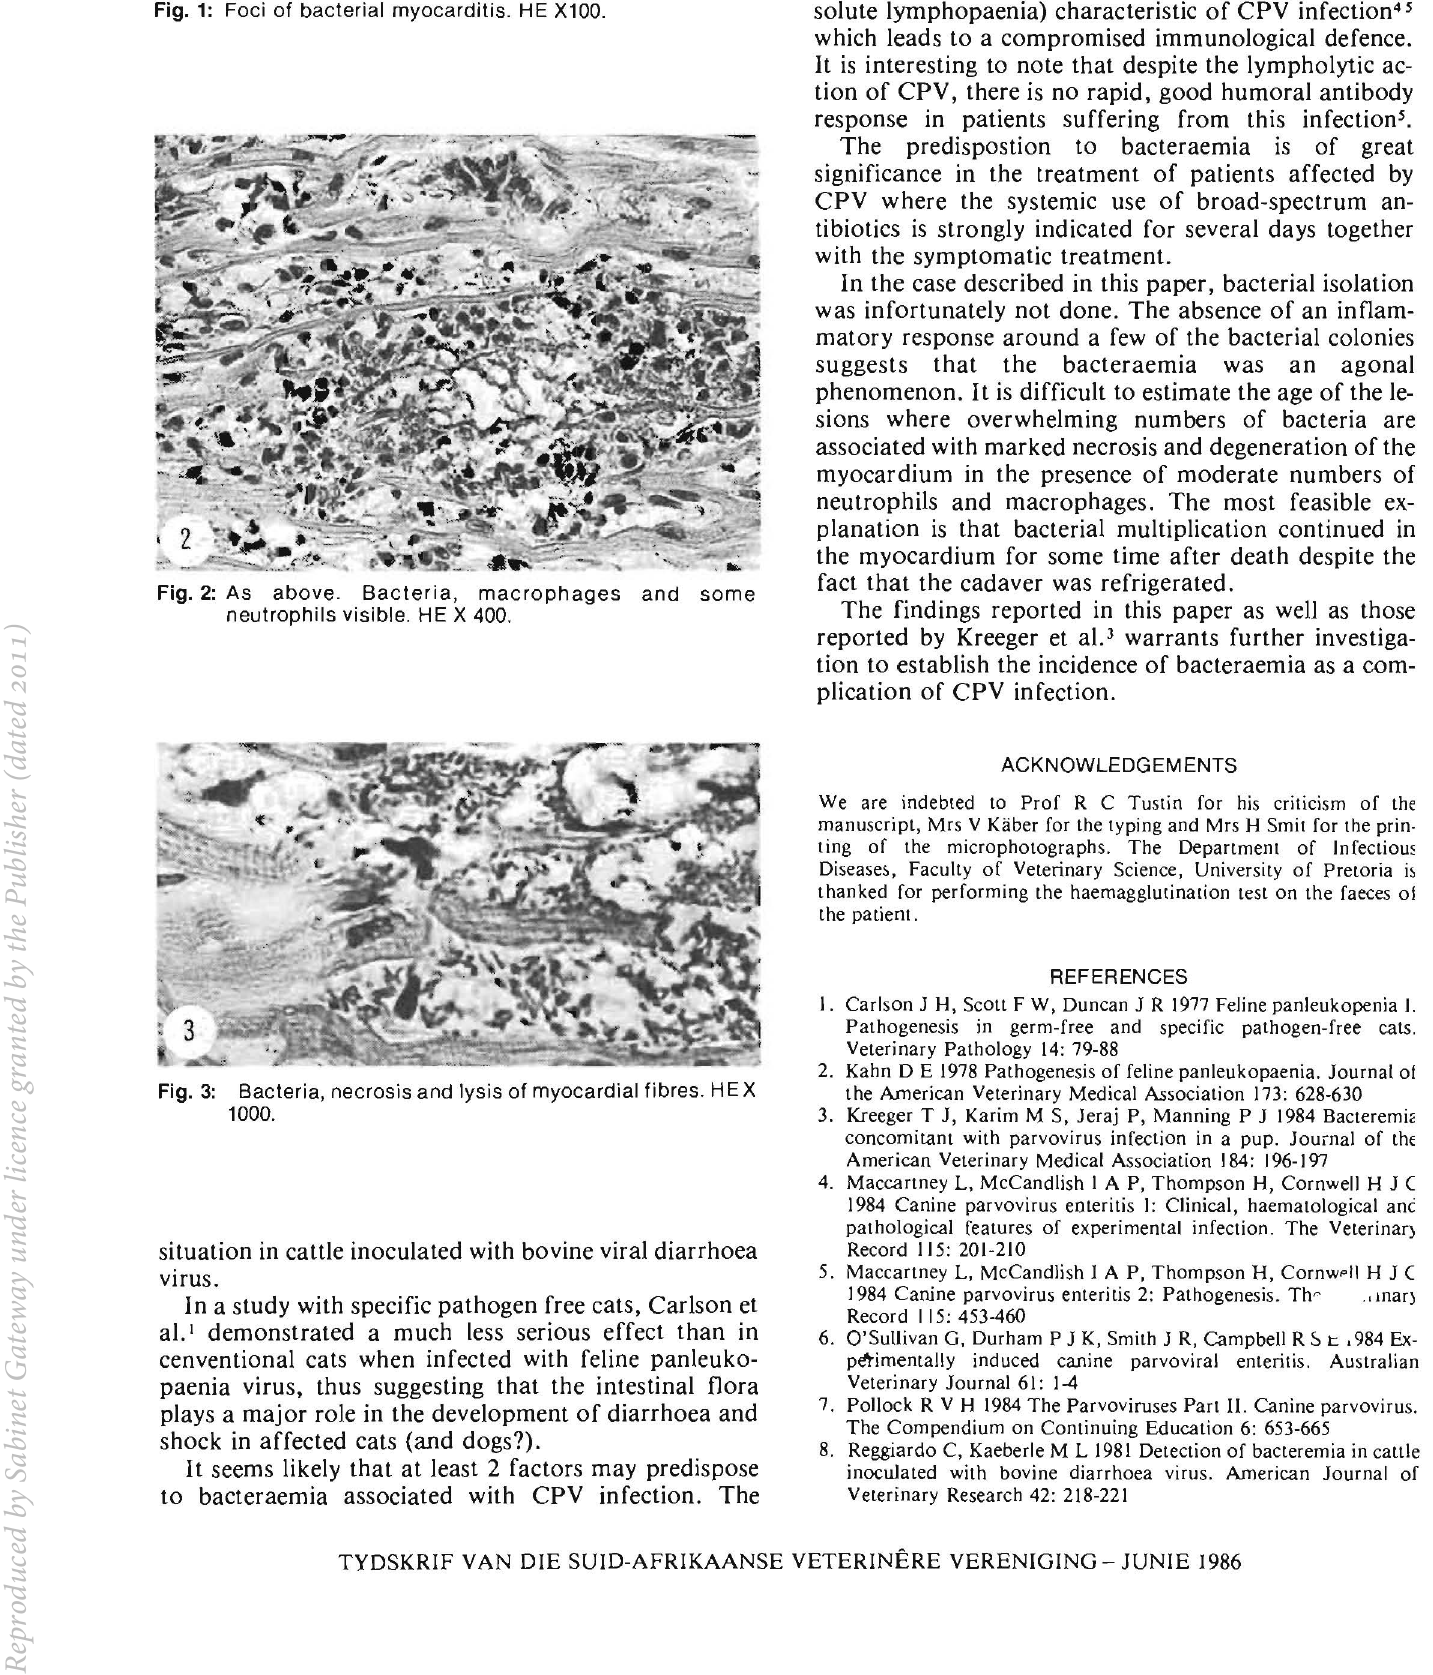
Fig. 1: Foci of bacterial myocarditis. HE X100.